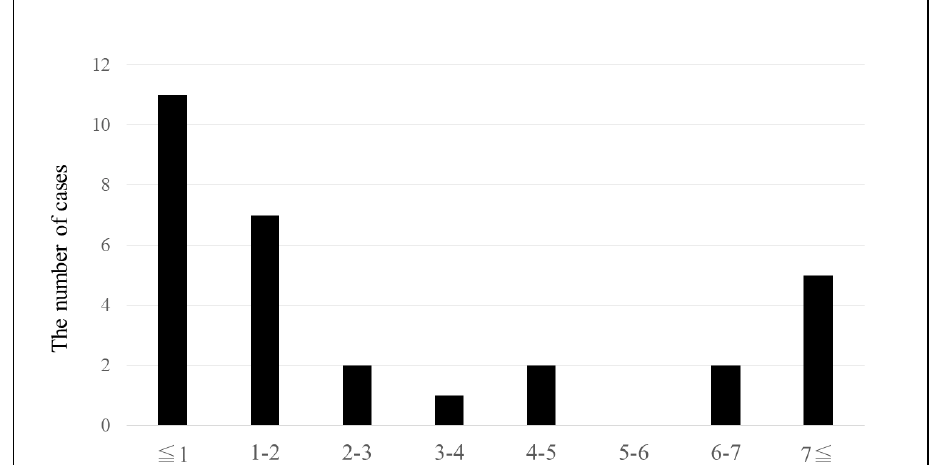
Figure 2. Duration of hemorrhagic stroke after blood pressure >140/90 mmHg (red line indicates pregnant women with chronic hypertension or gestational hypertension whose blood pressure was greater than 140/90 mmHg).